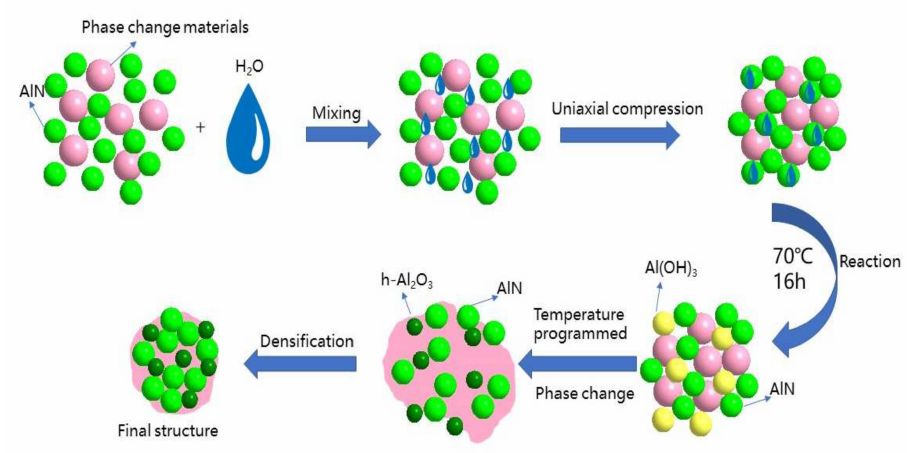
Scheme 1. The synthesis process of the constant solid-state